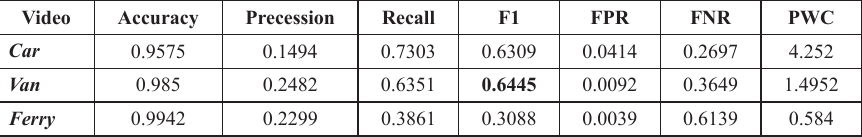
Table 5. Performance metrics results of applying GMM model